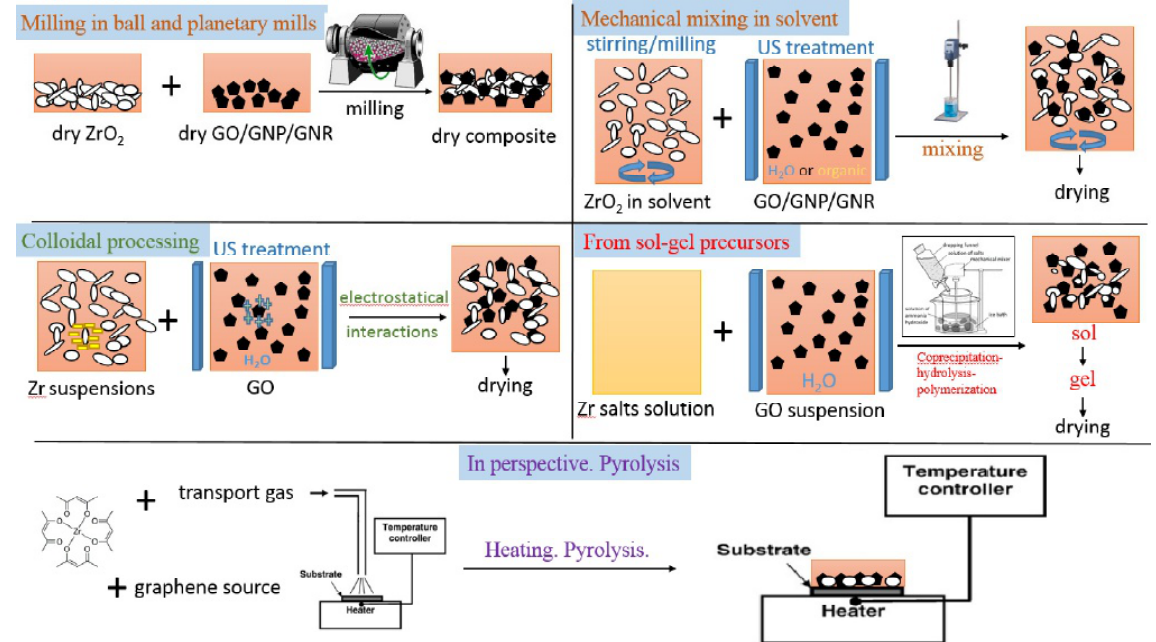
Fig. 4. Mechanisms applied for the precursor powder homogenization, based on data reported in